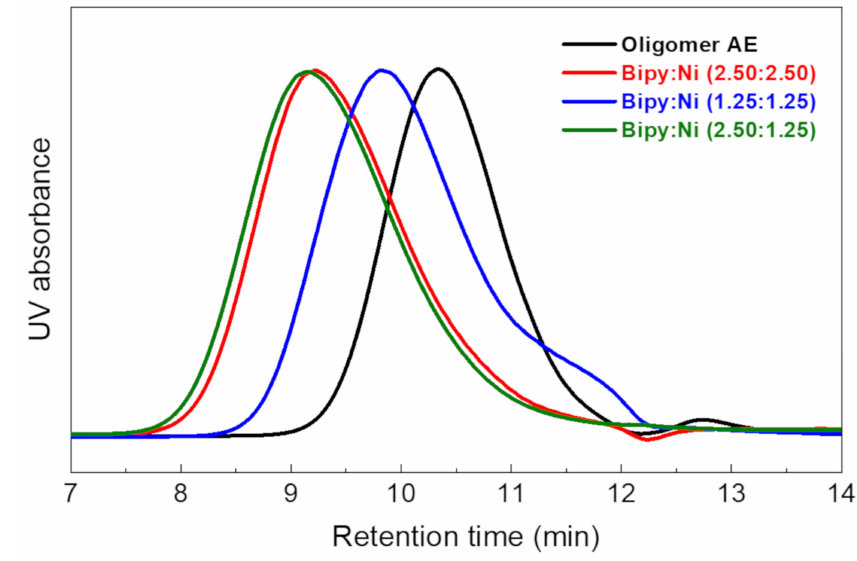
Figure 8. GPC traces of A-Polymer